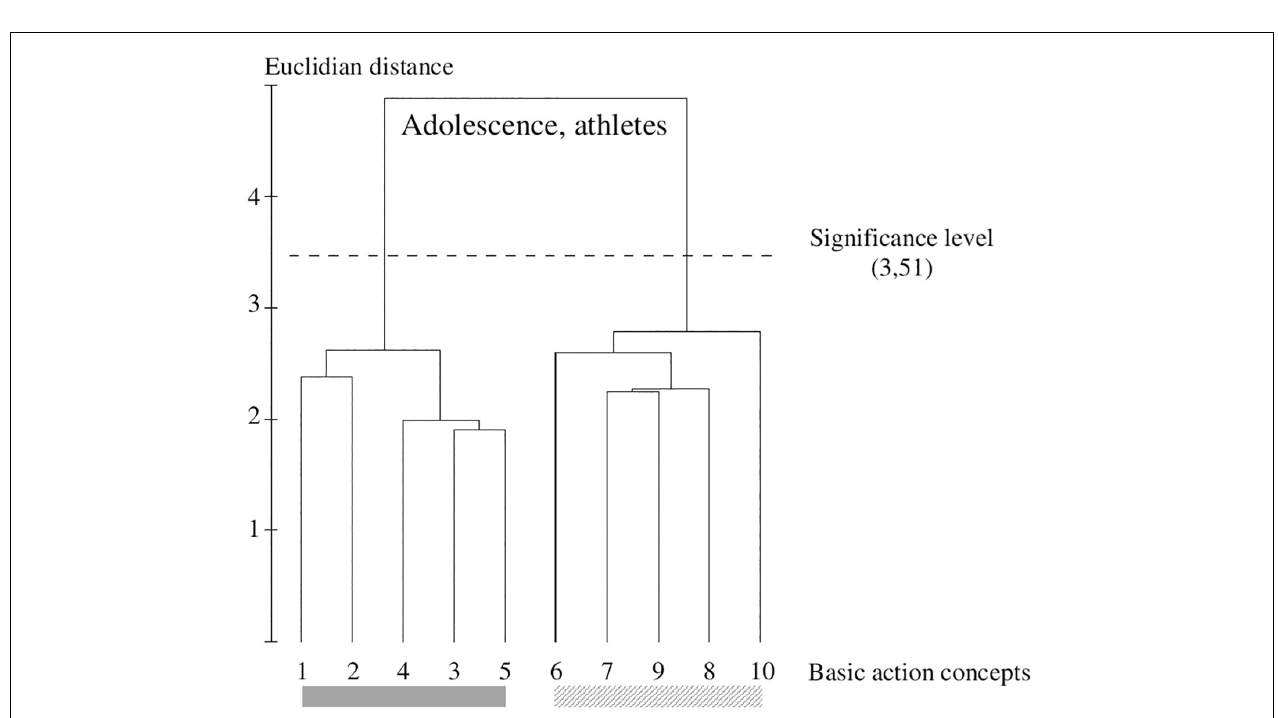
FIGURE 7 | Outcome of the hierarchical cluster analysis of athletes within adolescents ( N = 20) displayed as a dendrogram. The dashed line clarifies the critical value of d crit = 3.51, which corresponds to a significance level of 5%. The BACs are marked with numbers among the dendrogram and highlighted with the gray solid bar (technically correct BAC) and diagonally striped bar (faulty